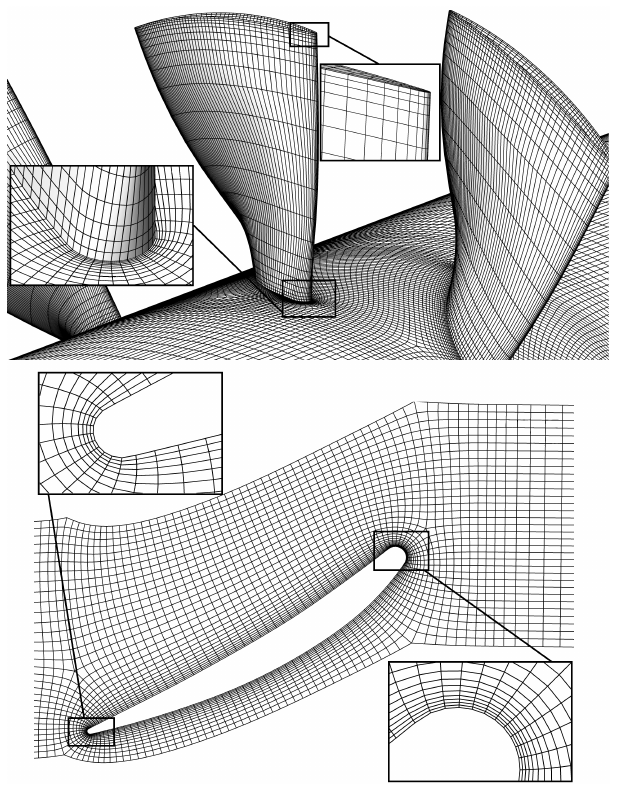
Figure 3. Solid surface mesh structure.